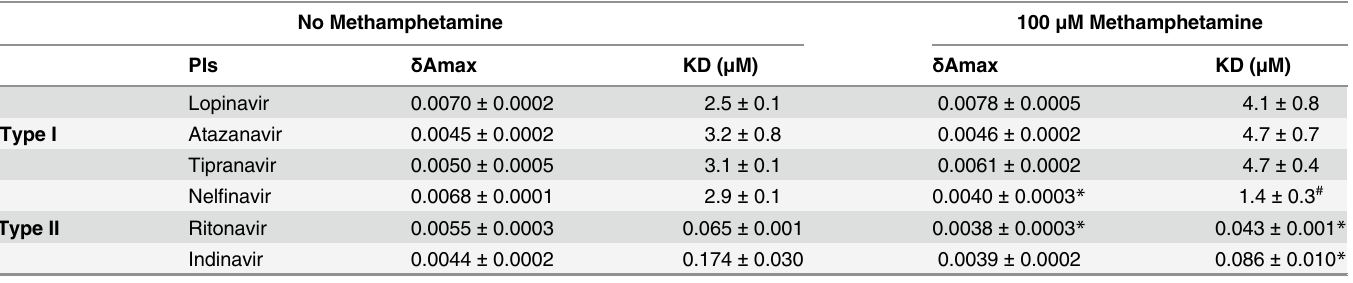
Table 2. The K D and δ A max of all the PIs with and without